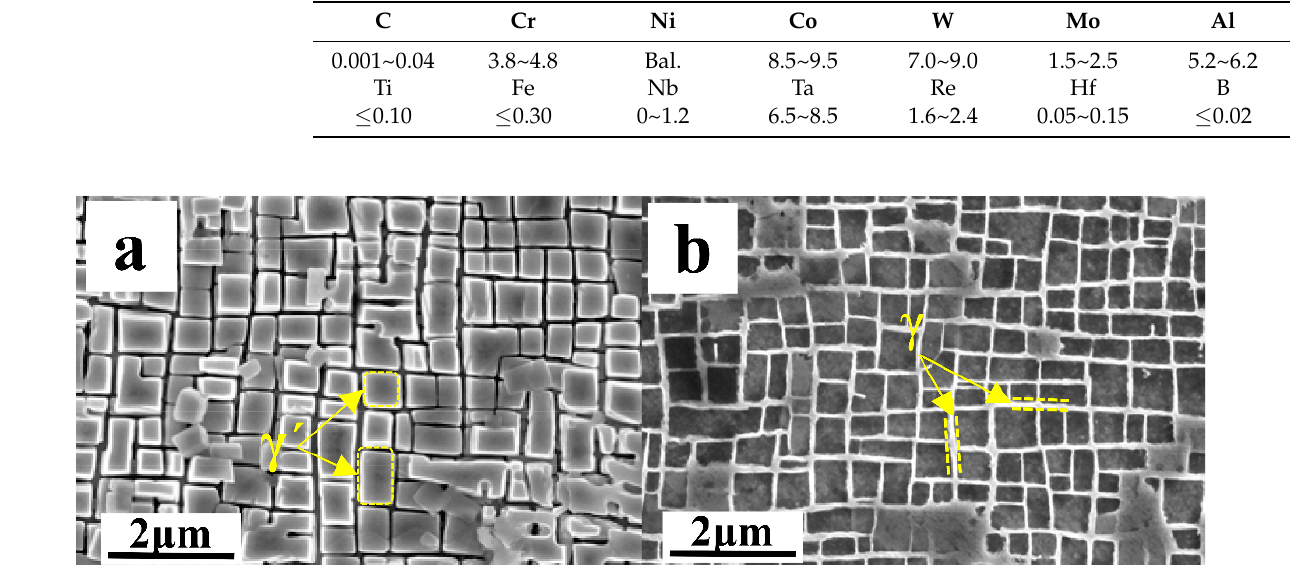
Figure 1. The original microstructure of the test alloy. ( a ) Electrochemical etching, ( b ) chemical etching.